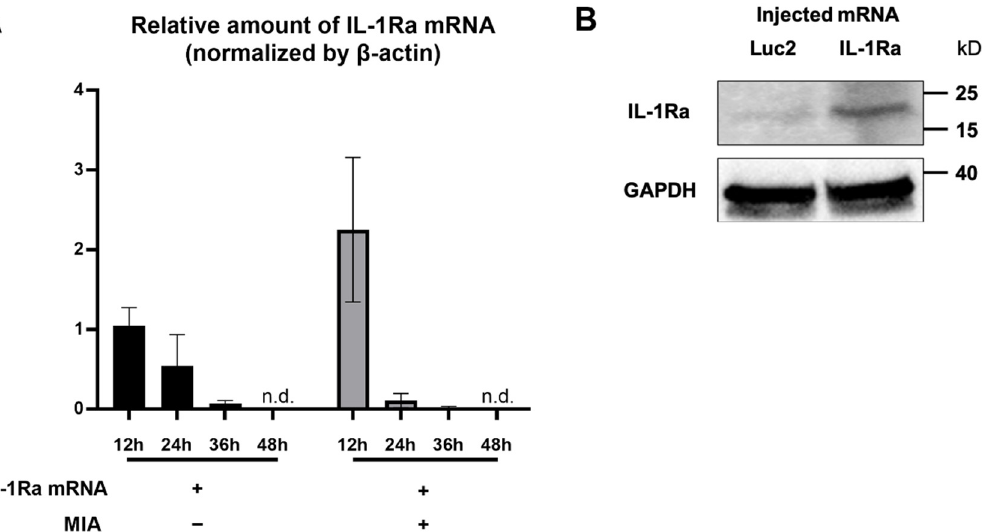
Figure 2. Transient interleukin-1 receptor antagonist (IL-1Ra) protein production from the exoge- nous mRNA delivered into the articular cartilage. ( A ) Relative amount of the exogenous IL-1Ra mRNA detected in the cartilage tissue by qRT-PCR at 12, 24, 36, and 48 h after the mRNA injection. n = 3/group. Data are presented as mean ± SEM. n.d., not detected. ( B ) Protein production of IL-1Ra from the exogenous mRNA at 24 h post mRNA injection, evaluated by Western blotting. Luciferase 2 (Luc2) mRNA was used as a negative control.